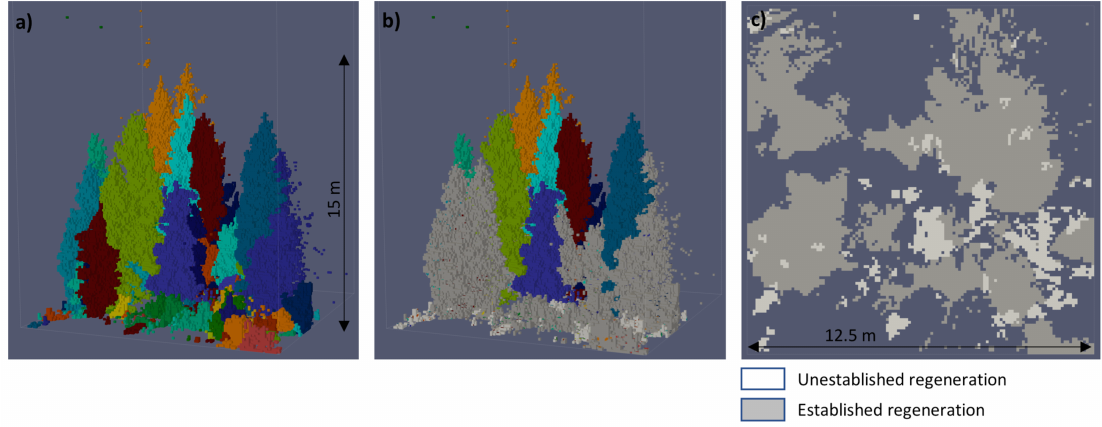
Figure 4. Exemplary visualisation of the results from the regeneration ground cover estimation. Image ( a ) shows the previously isolated trees within a plot quadrant. From these tree objects two classes of regeneration have been extracted in image ( b ). For the ground cover computation, the regeneration has been vertically projected onto a 2D surface. Image ( c ) maps the footprints of both regeneration